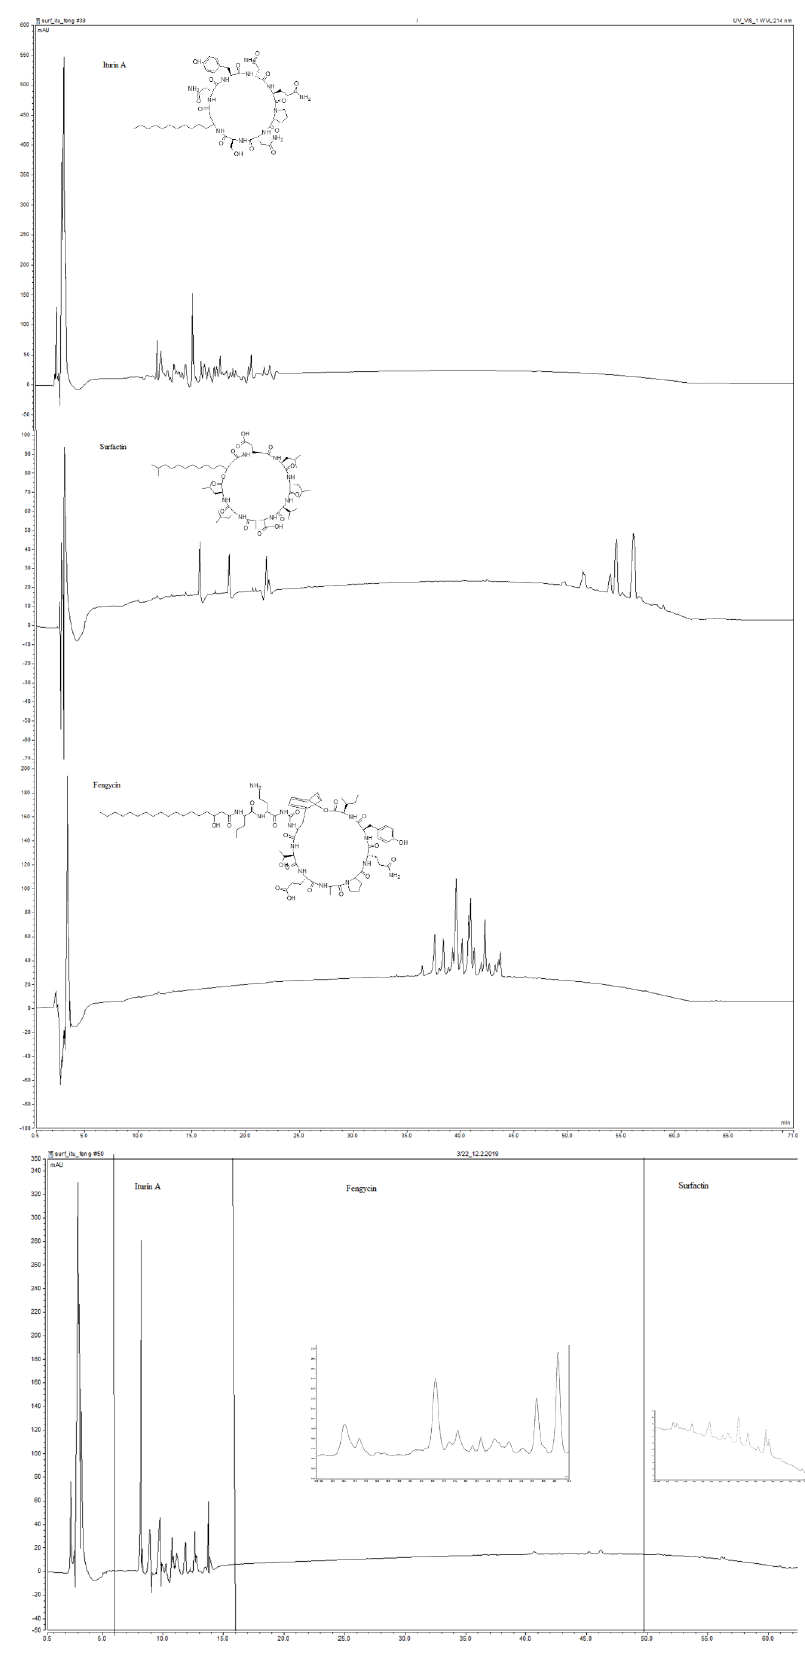
Figure 1. Chromatogram of standards ( up ) and LPs from B. amyloliquefaciens 3/22 ( down ), containing components of iturin A, surfactin and